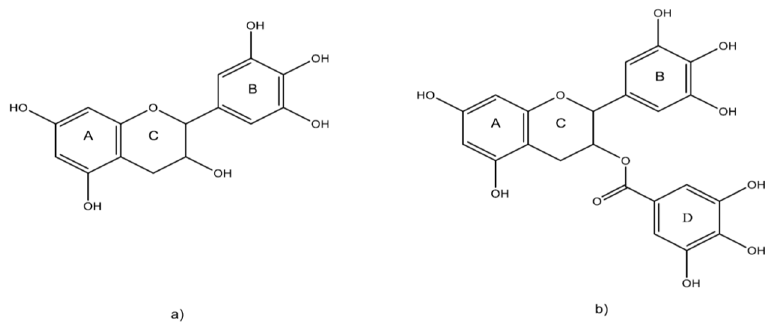
Figure 4. ( a ) Basic structure of catechin. ( b ) Chemical structure of